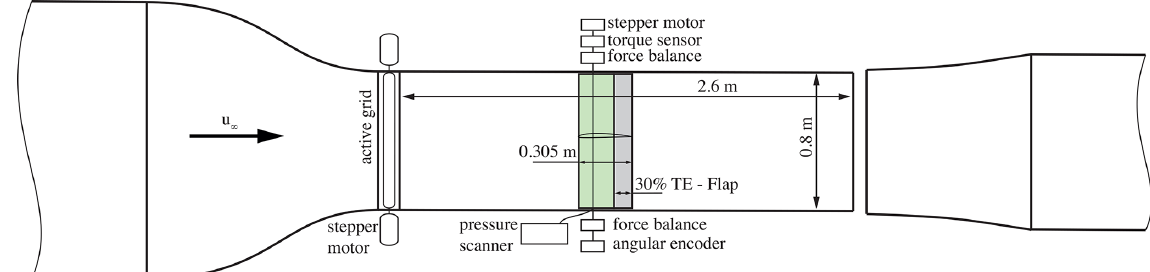
Figure 1. Wind tunnel setup with active grid, closed test section and installed 2D airfoil.